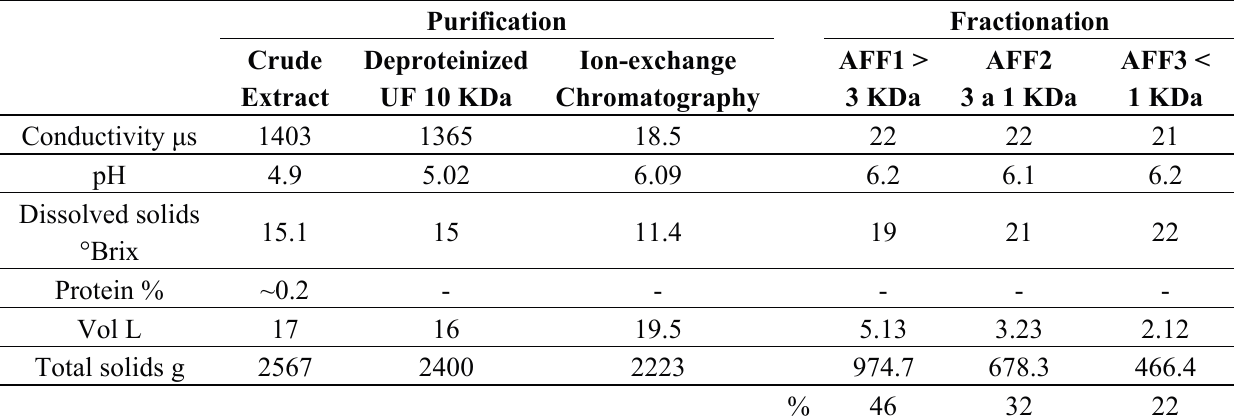
Table 1. Purification and fractionation monitoring of the Agave angustifolia Haw fructans.